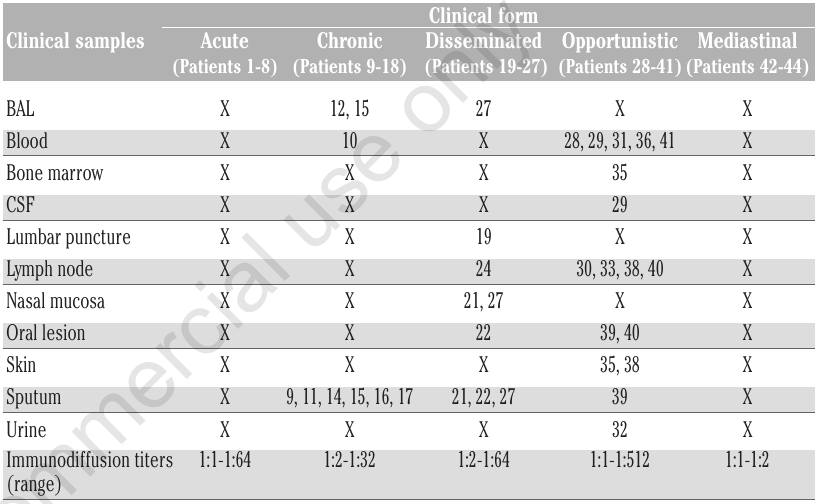
Table 3. Description of the isolation of H. capsulatum from the clinical samples of the 44 patients at the time of diagnosis. Single numbers identify samples isolated from a spe- cific individual and in some cases, multiple samples showed positivity for growth of H. capsulatum.